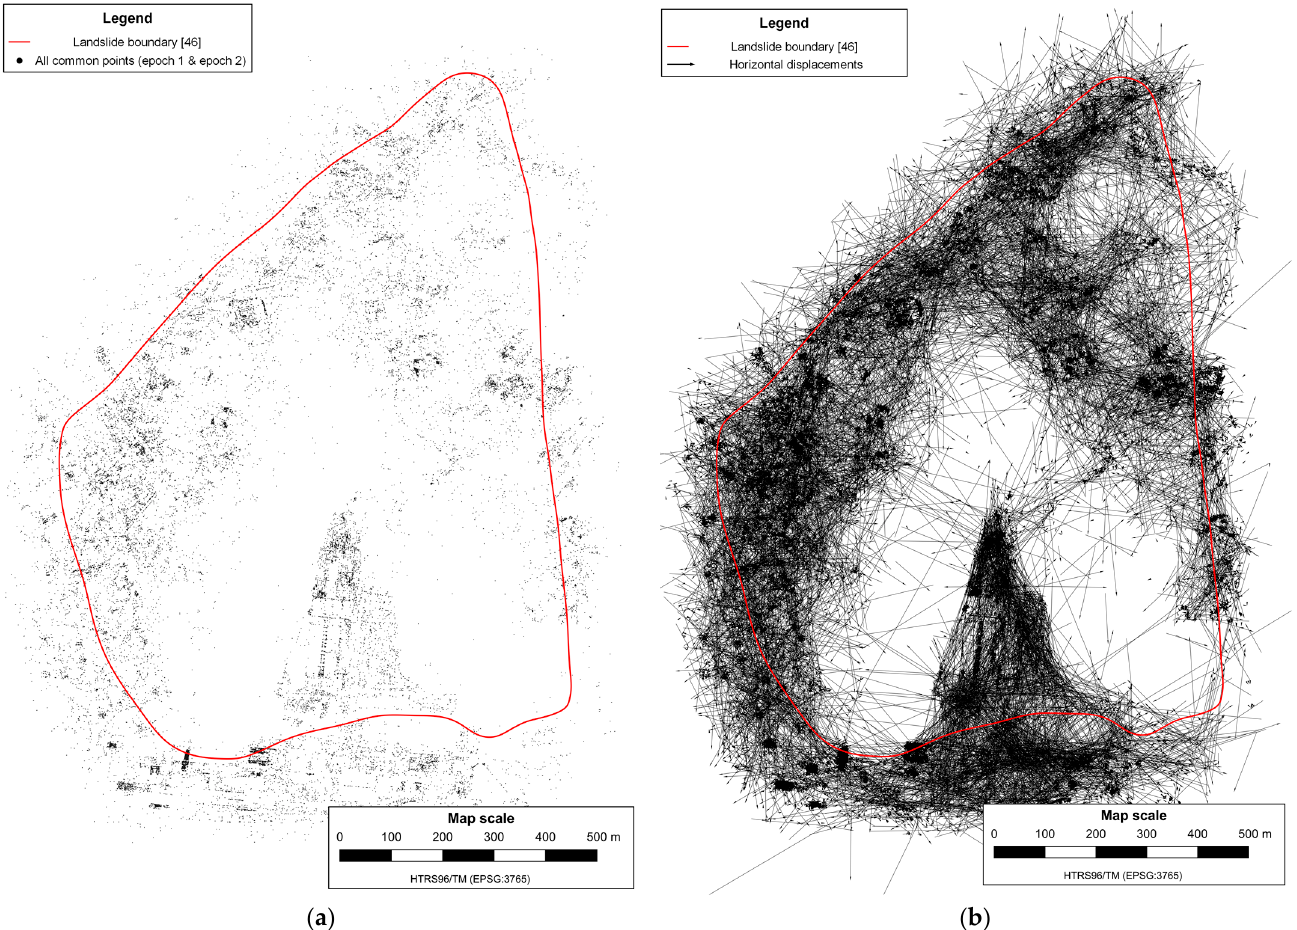
Figure 13. All reconstructed common feature points in both epochs ( a ), and determined horizontal displacements vectors ( b ).